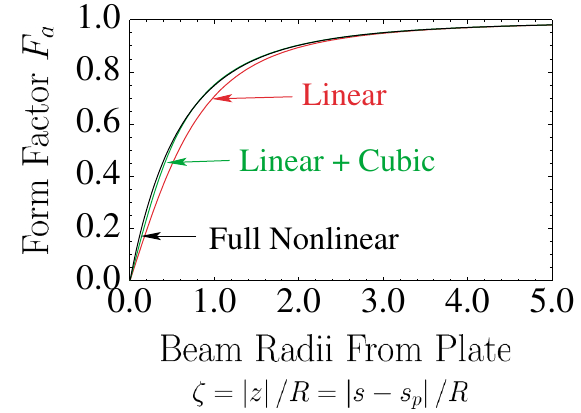
FIG. 5. (Color) Form factor F for the axisymmetric envelope a equation (20) in full nonlinear form [black, Eq. (18) or (19)] and with linear and linear plus cubic nonlinear approximations j =R [red and green, Eq. (25)] plotted versus , (cid:1) j s (cid:2) s p